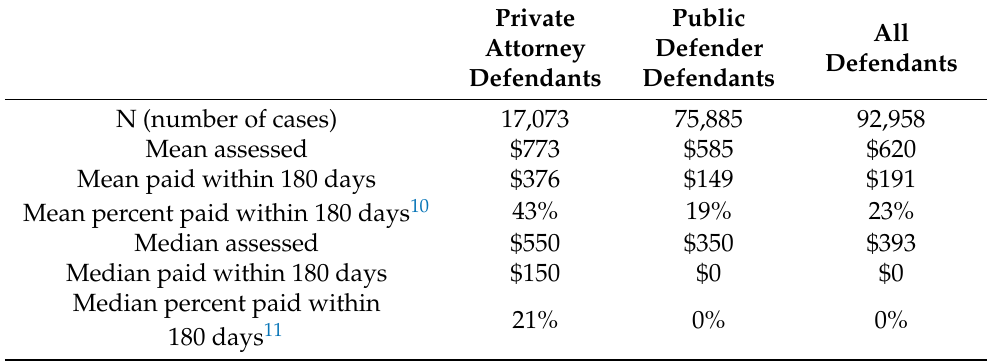
Table 2. Mean and median LFO assessments, payments within 180 days of assessment, and rates of payment within 180 days of